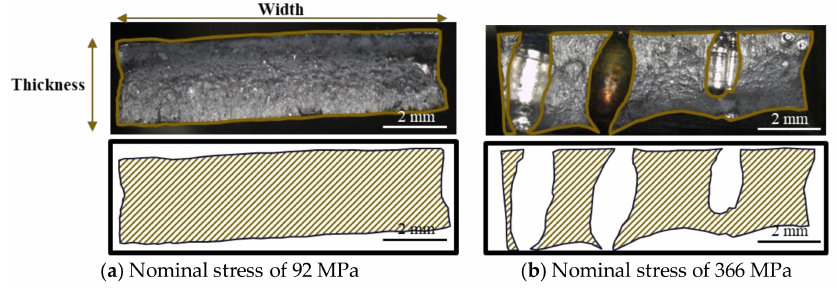
Figure 14. Fatigue fracture surfaces of the type III specimen after fatigue test at the nominal stresses of 92 MPa and 366 MPa.